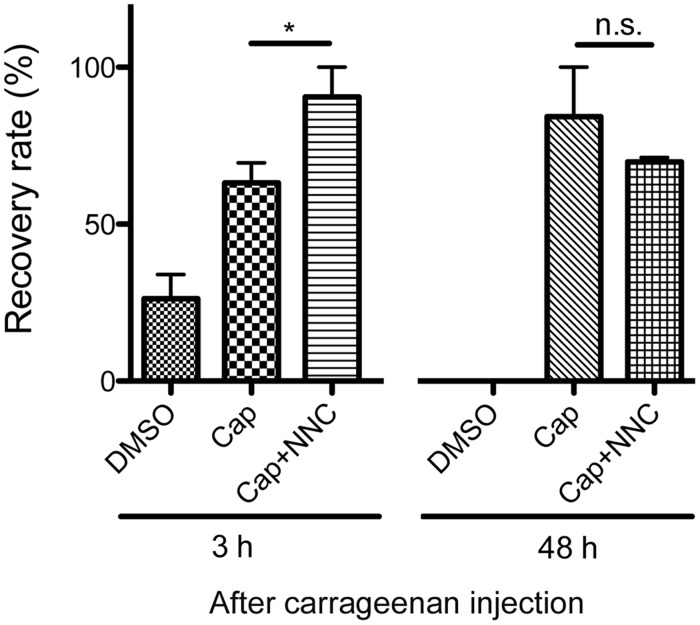
Recovery rates from hyperalgesia after intraplantar injections of capsaicin (cap) or capsaicin and NNC 55–0396 (cap+NNC).At 2 h or 2 days following carrageenan injection, DMSO (control), cap or cap+NNC was injected, and PWTs were evaluated after 1 h, 3 h or 48 h. The data are expressed as relative values, with the recovery rate to baseline of the individual being 100% (n = 3–5 mice for each group). *p < 0.05 compared with capsaicin-treated mice (unpaired Student's t-test). n.s., not significant.